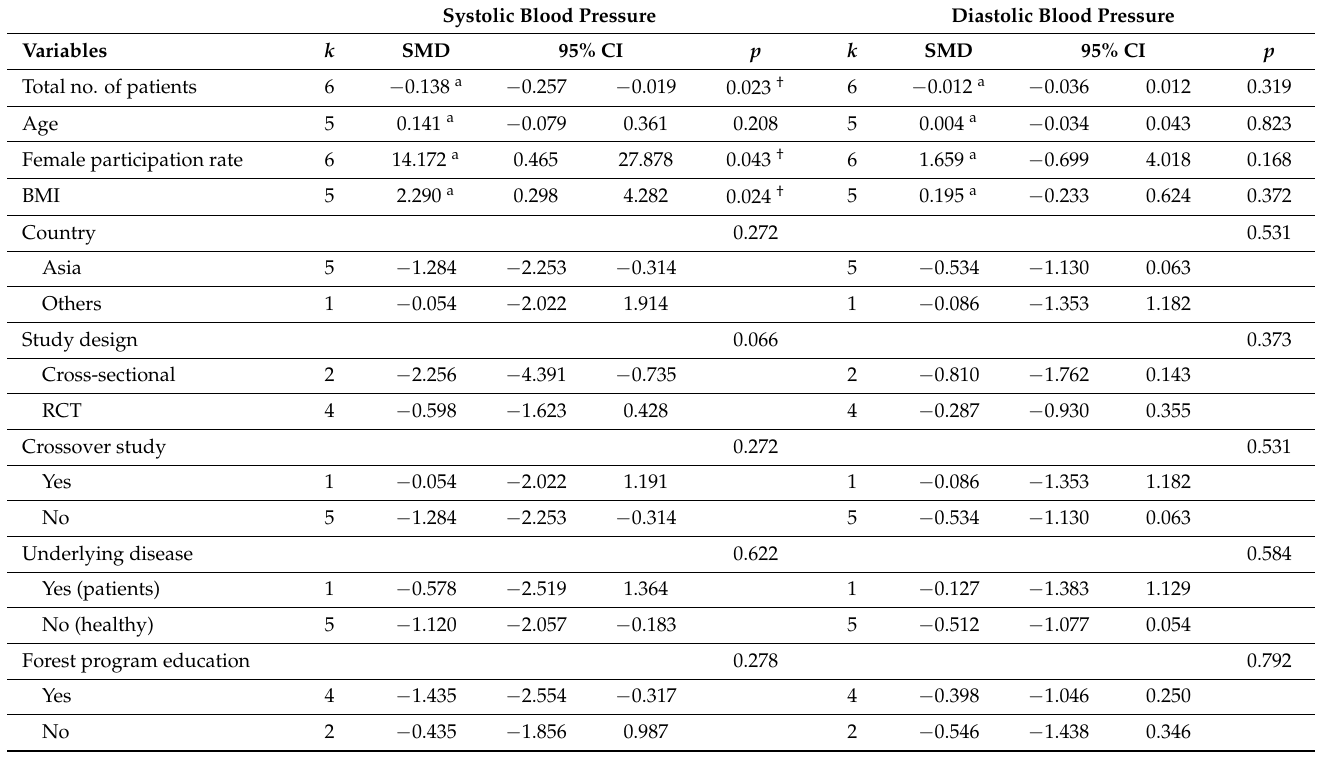
Table 3. Results of the meta-regression analysis of the effects of forest therapy